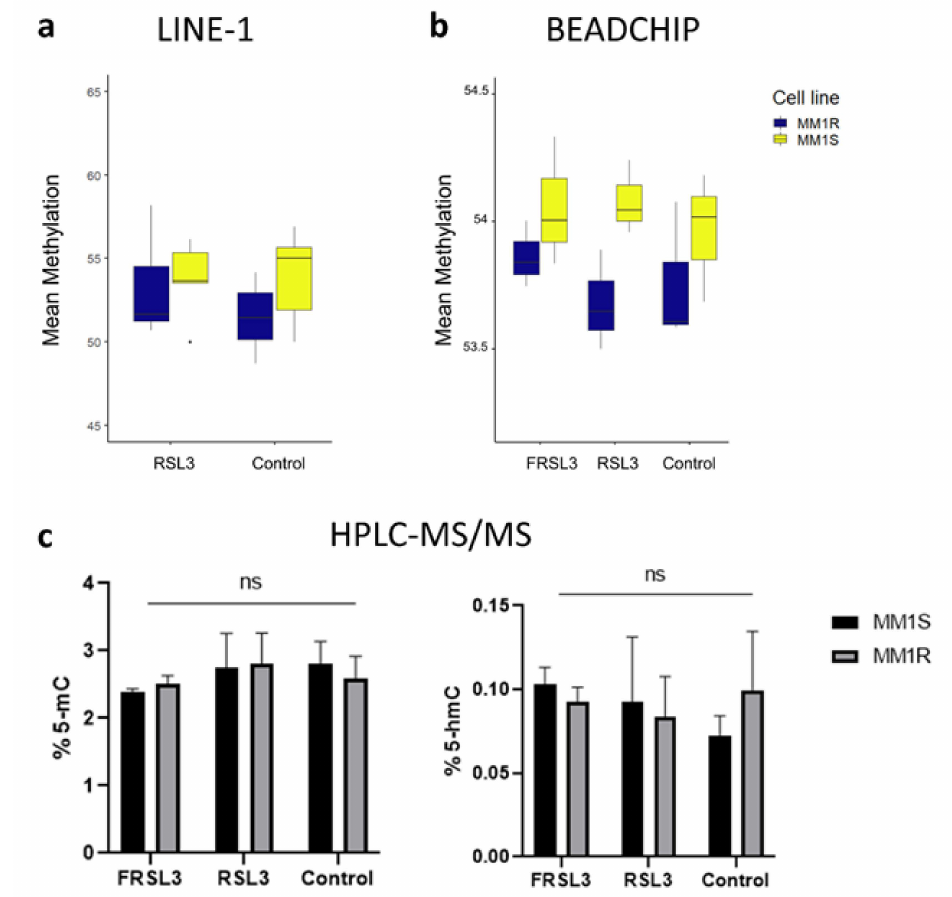
Figure 5. Global DNA methylation changes in MM1 cells after RSL3 treatment (with or without pre-treatment of ferrostatin-1 (FRSL3)). ( a ) Mean methylation levels (%) of 3 CpGs located in long interspersed nuclear elements 1 (LINE-1), n = 3 biologically independent replicates. ( b ) Mean methy- lation levels (%) of 866.836 genome-wide CpG sites analyzed with the Illumina Infinium Methylation EPIC BeadChip, n = 3 biologically independent replicates. ( c ) Mean % of 5-methylcytosine (left) and 5-hydorxymethylcytosine (right) residues present in MM1 samples. Data are represented as the mean ± s.d. (ns = p > 0.05, ANOVA), n = 3 biologically independent